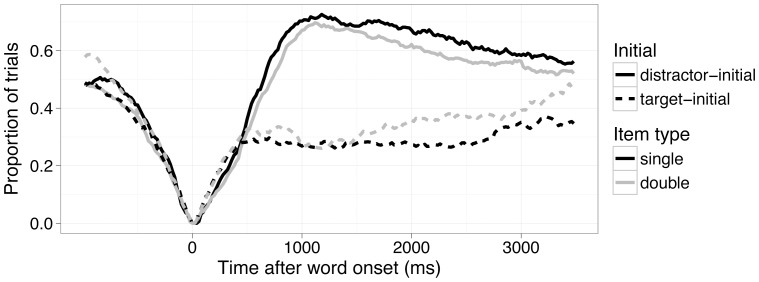
Target fixation, split by initially fixated object and trial-type.This onset-contingent timecourse plot shows, for each unit of time, the proportion of trials in which children are currently fixating an image that is not the one they fixated when the target word began; thus, all trials have a y-value of 0 at time 0. The x-axis shows time, beginning at the onset of the target word. Solid lines show distractor-initial trials, dashed lines show target-initial trials. Grey lines show trials in which doubles are the target, black lines show trials in which singles are the target. On distractor-initial trials, toddlers quickly looked away from the distractor, seen by the fast rise in the solid lines. There is no difference between the single and double performance. In this type of graph, strong performance is demonstrated by the target-initial trials remaining flat near zero, while the distractor-initial trials rapidly rise from 0 towards 1 (See text for further details).